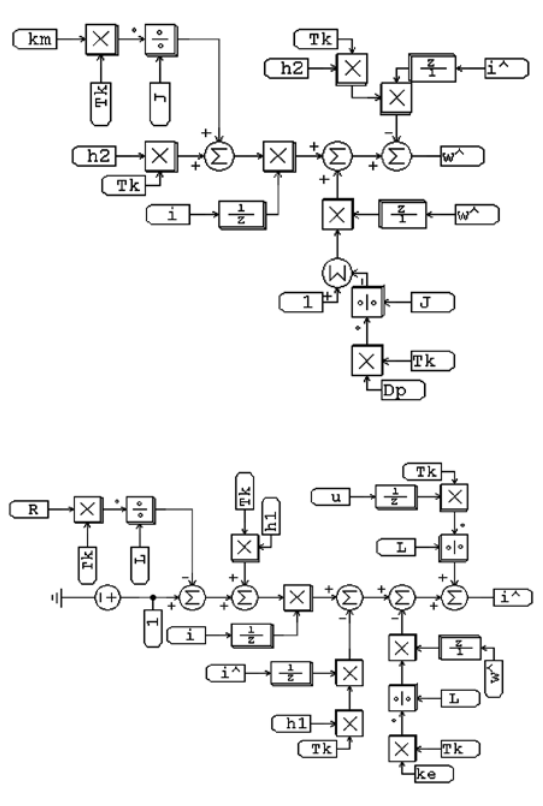
Fig. 2. Diagrams illustrating the speed and sum of the calculation of currents